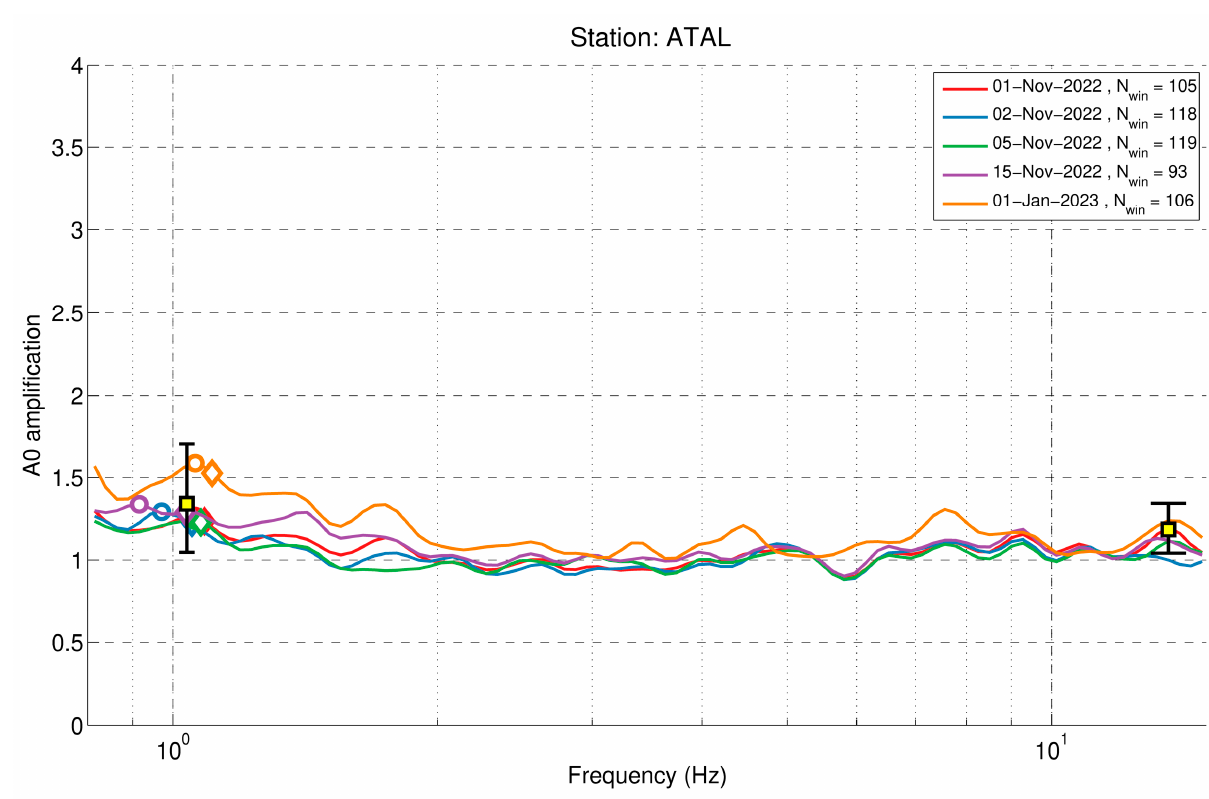
Figure 16. Average HVSR curves (solid lines) determined for station ATAL on different days, from 60 s long windows selected after the application of STA/LTA anti-triggering on 6 h long records. Circles denote the global frequency on each curve, while diamond symbols mark the average of the frequency band denoting the range of peak frequencies of the HVSR lines from the individually selected windows (light/dark gray band in Figure 2b). Squares mark the prominent global and secondary peak frequencies recognized from the HVSR spectra, with error bars indicating the uncertainty of the amplification factor (Table A1).